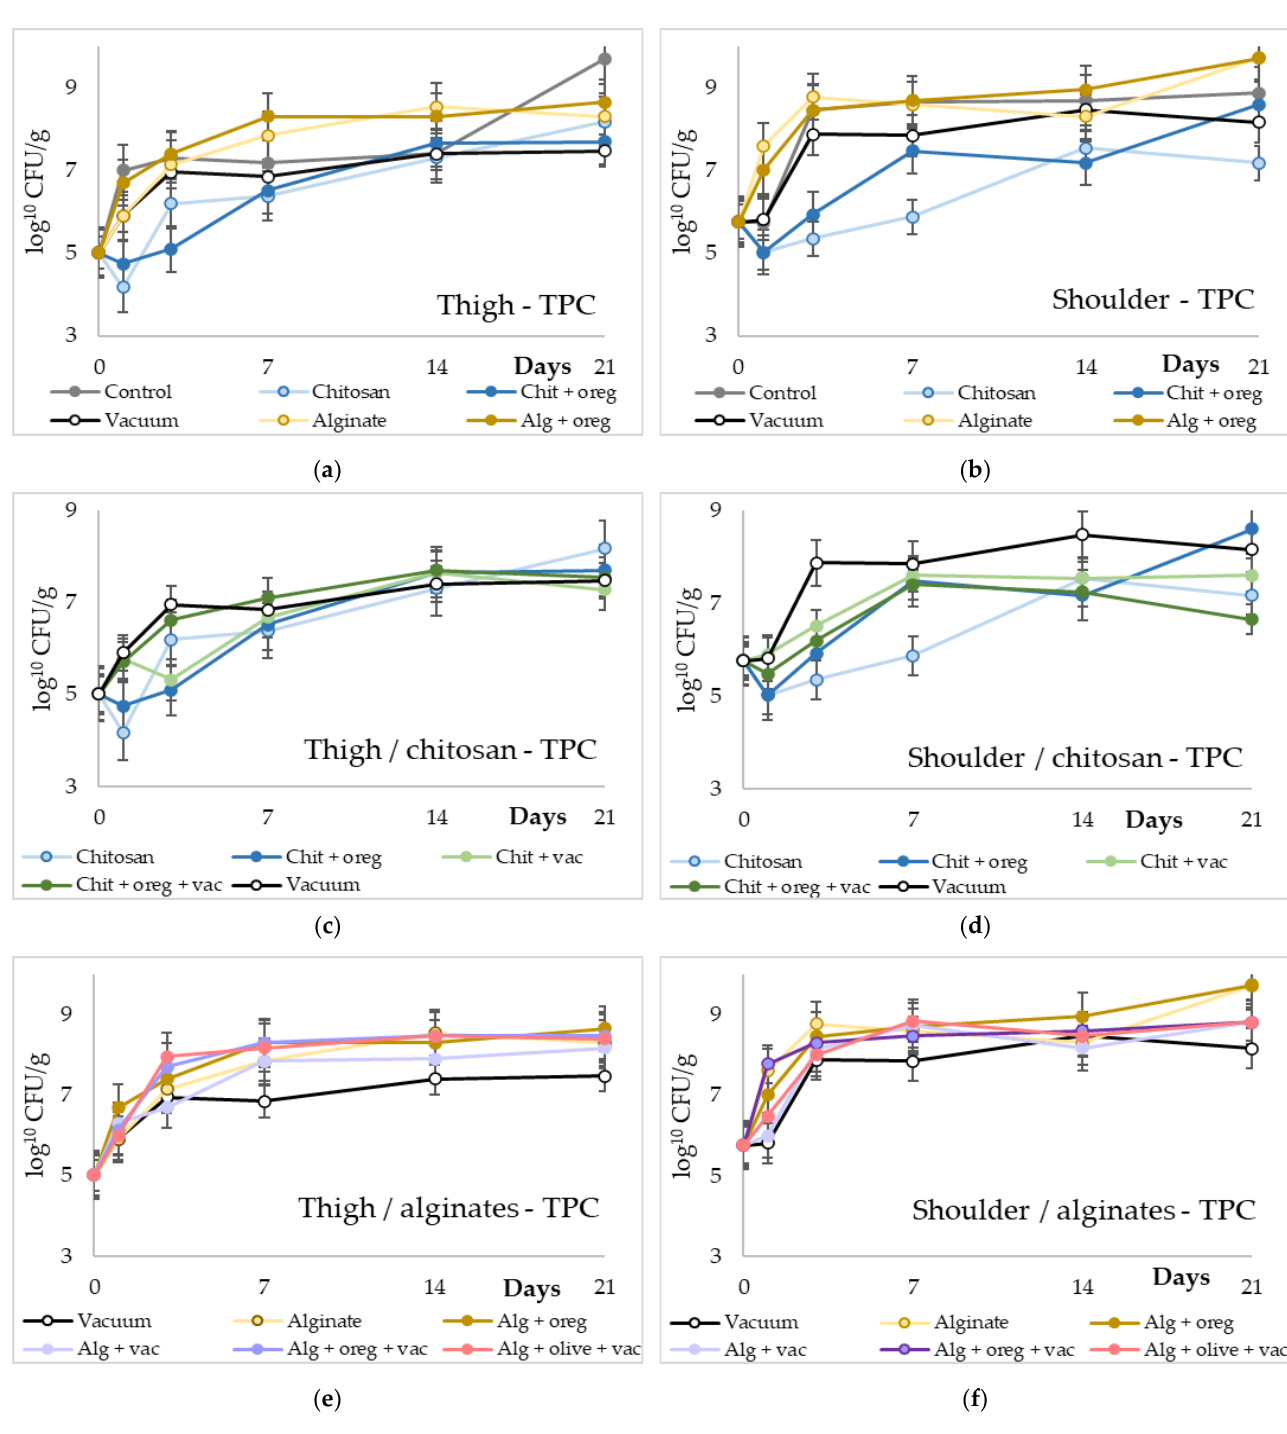
Figure 2. Total Psychrophilic Counts (log10 cfu/g) of meat pieces over time (days). ( a , b ) TPC of control lots against chitosan or alginate coating with or without vacuum packaging in thigh and shoulder pieces; ( c , d ) TPC of different chitosan treatments in thigh and shoulder pieces; ( e , f ) TPC of different alginate treatments in thigh and shoulder pieces. (Chit: chitosan coating; oreg: oregano essential oil; vac: vacuum packaging; Alg: alginate coating; olive: olive oil addition).